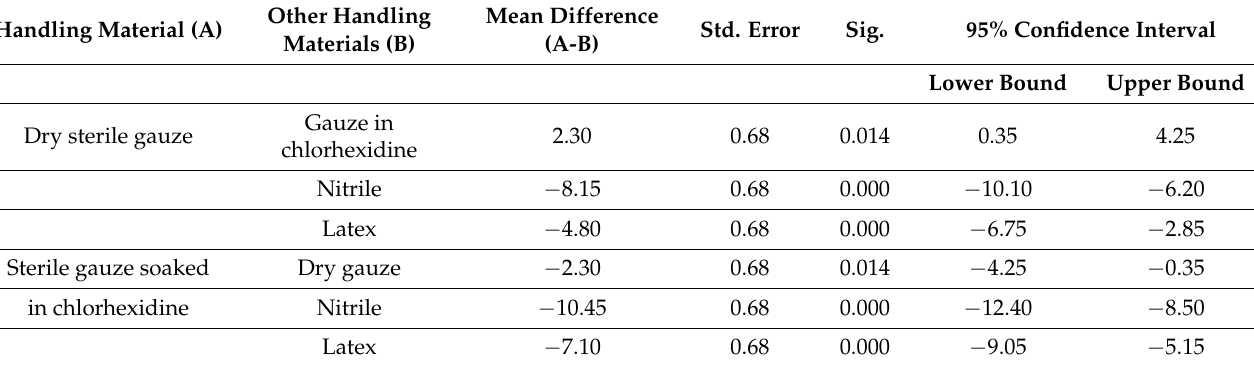
Table 1. Comparison of number of particles left on the region of interest (ROI) of OMIs by each of the gauzes (dry or soaked in chlorhexidine) on one hand, and the other handling materials (gauze, nitrile and latex) on the other hand. Note significant differences between the number of particles left by the nitrile glove when compared with the gauze.